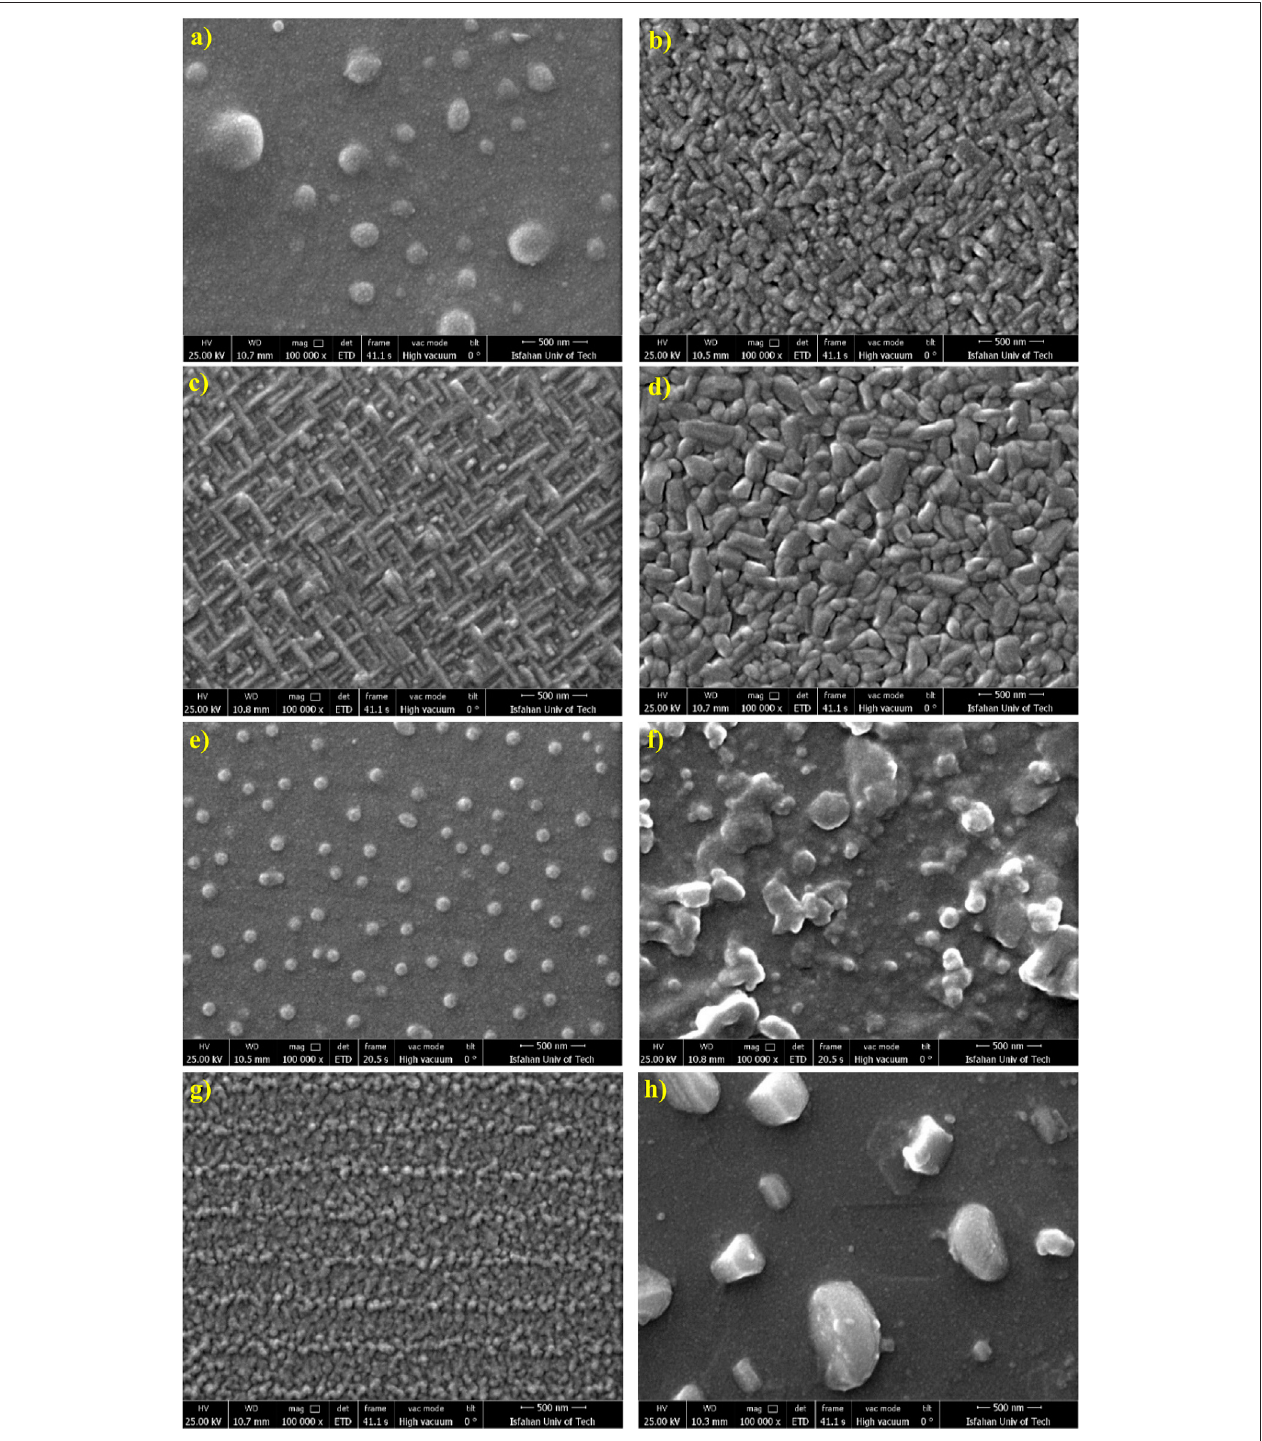
FIGURE4| SEMimagesof fi lms. (A) Surfaceof fi lmSALO, (B) surfaceof fi lmAALO, (C) surfaceof fi lmSSTO, (D) surfaceof fi lmASTO, (E) surfaceof fi lmSZnO, (F) surface of fi lm AZnO, (G) surface of fi lm SLNO, and (H) surface of fi lm ALNO. 2017). Also, a blue shift is observed for fi lms on STO substrates (SAlO) related to the A 1g mode of SrM cm − 1 SAlOwhich shifts to that increases with the annealing of the sample, but the shift is less 715 cm − 1 after annealing (AAlO), con fi rming the existence of a pronounced compressive strain (Kreisel et al., 1998; Zhang et al., than that for the fi lm on the Al 2 O 3 substrate. It can be observed in